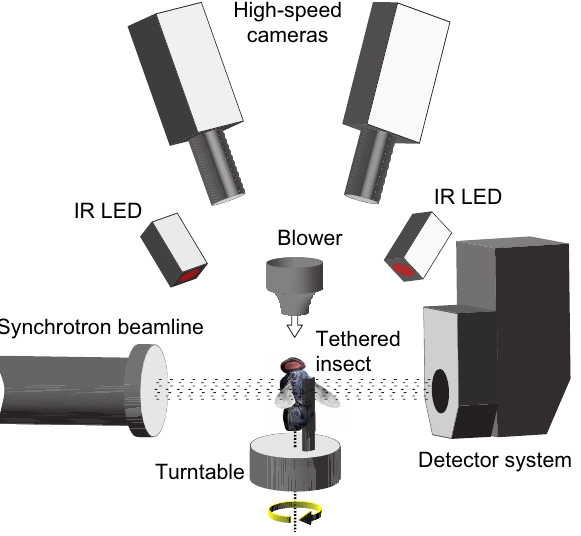
Figure 1. Schematic diagram of the experimental setup, showing the direction of the wind stimuli (white arrow) and rotational stimuli (yellow arrow).